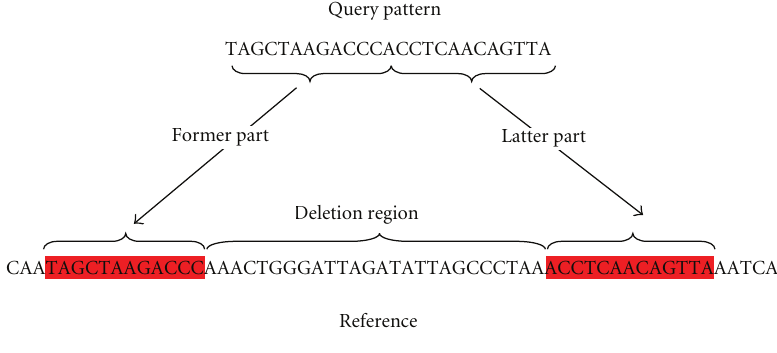
Figure 1: A demonstrative example of large